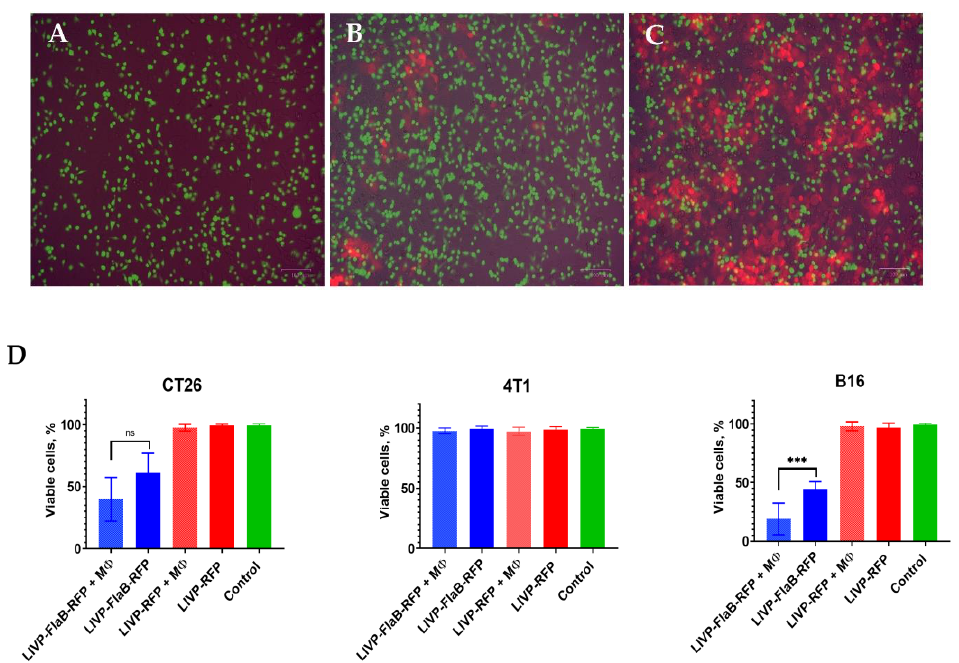
Figure 5. Macrophage cytolytic effect. Microscopic pictures (20 × magnification, scale bar represents 100 µ m) of the B16 cells co-cultivated with RAW264.7, pre-stained with CellTracker Green ( A ) and infected with 0.1 MOI of LIVP-FlaB-RFP ( B ) or LIVP-RFP ( C ). ( D ) Qualitative assessment of cell viability using MTT assay at 48 h post-infection of co-cultivation, normalized to non-infected co- cultured cells as a control. For statistical analysis, an ANOVA test was performed; *** p < 0.001 indicates significance.